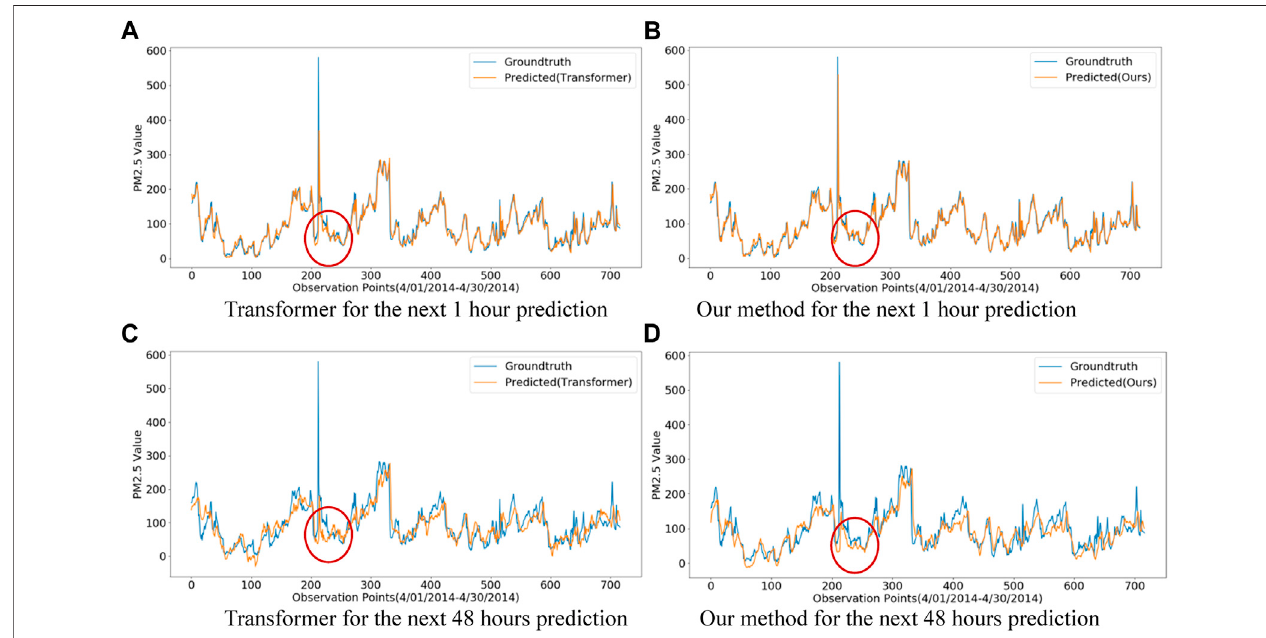
FIGURE14| Comparisonsofourmethodand Transformer onsingle-step (h1)and multi-step (h48)groundtruthandairquality prediction tasksduring 1 month (4/ 01/2014-4/30/2014) on Beijing dataset.